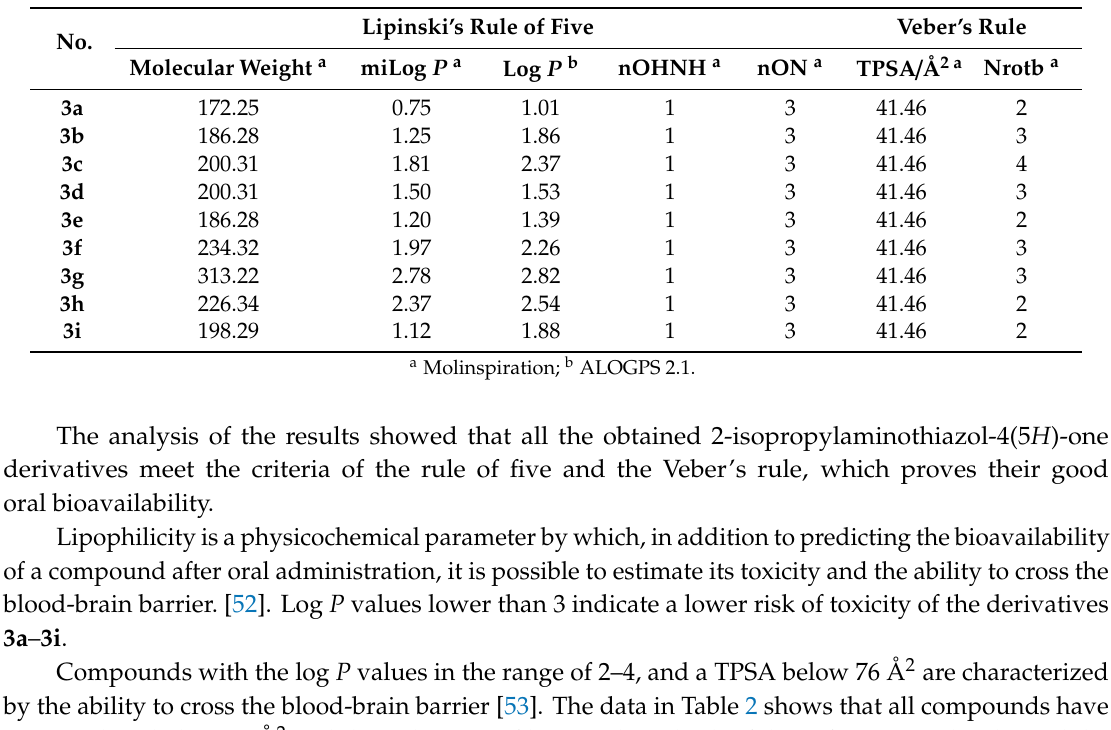
Table 2. Bioavailability parameters of 2-(isopropylamino)thiazol-4(5 H )-one derivatives calculated with the Molinspiration and ALOGPS 2.1